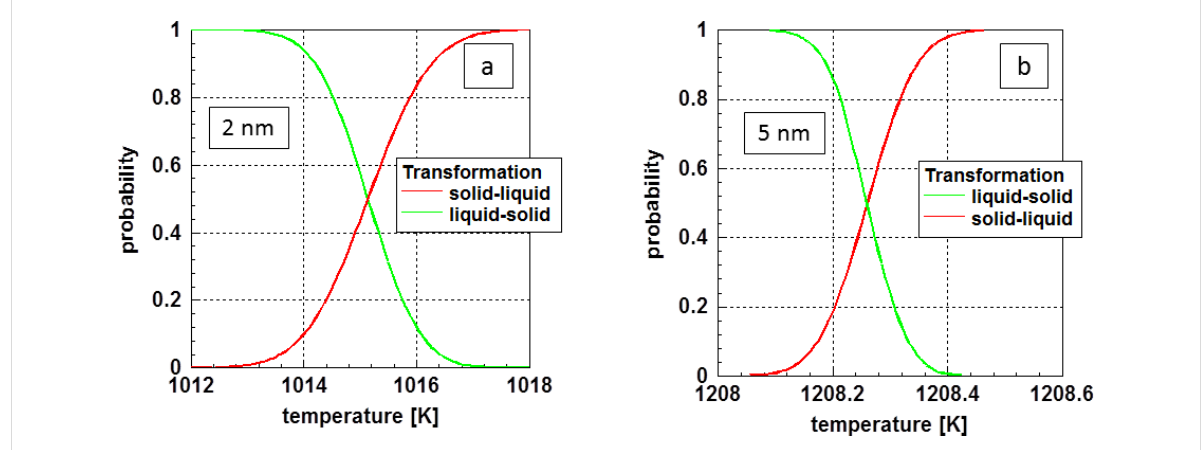
Figure 2: Probability for the transformation of (a) 2 nm and (b) 5 nm diameter gold particles in the vicinity of the melting